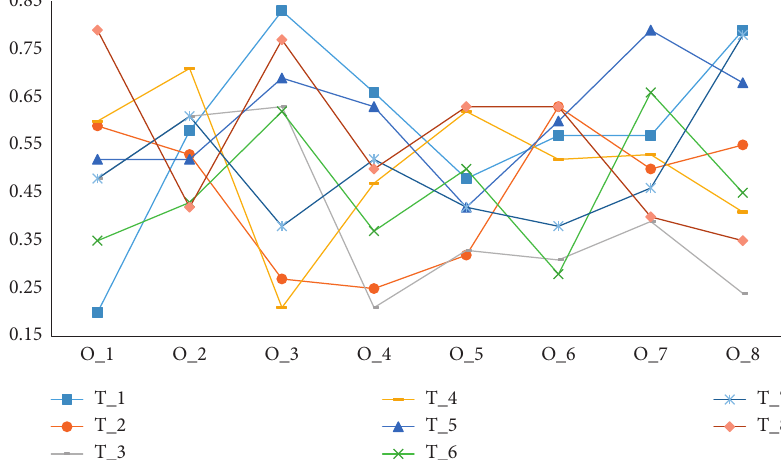
Figure 7: Comprehensive preference information of each subtask of each